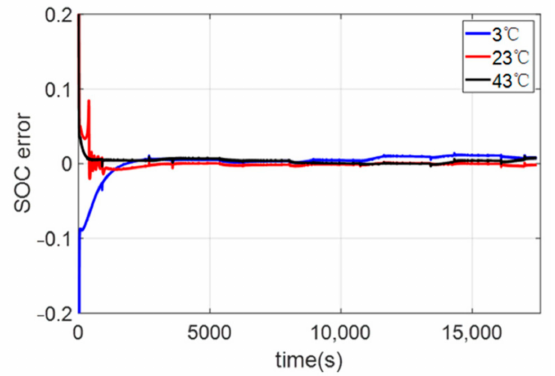
Figure 17. SOC estimation error for DST at different